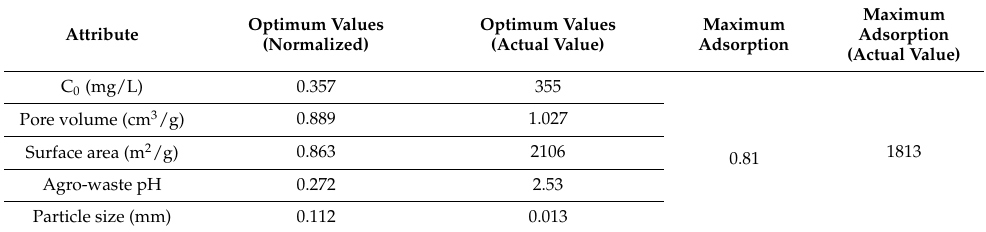
Table 8. The predicted importance of variables on the adsorption efficiency.